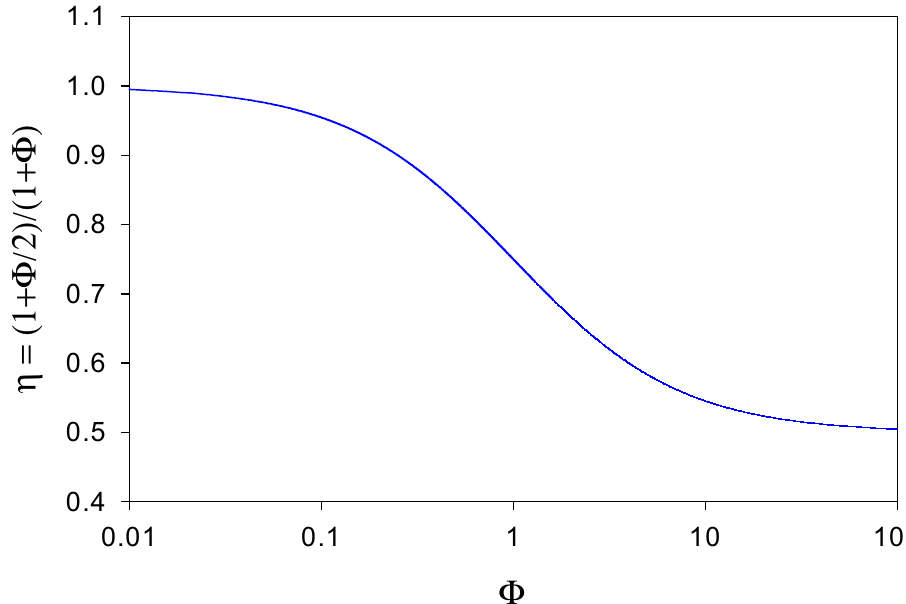
Figure 7. Variation of the flux efficiency factor η with the mediator diffusive flux ratio Φ